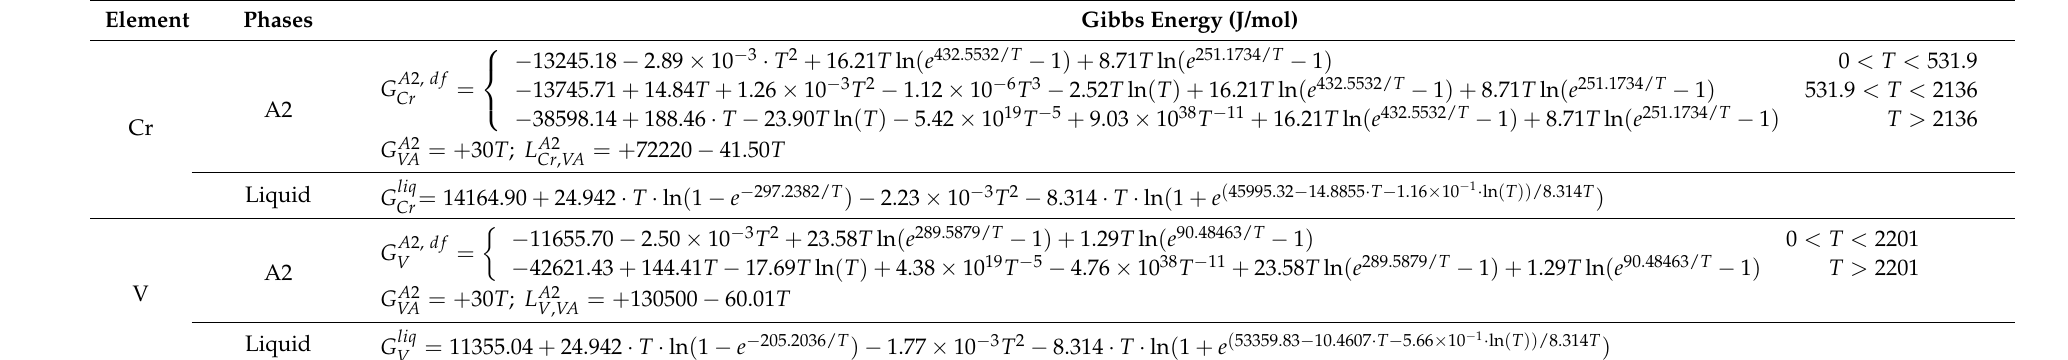
Table 1. The third-generation Gibbs energy expressions for pure Cr and V in solid A2 and liquid